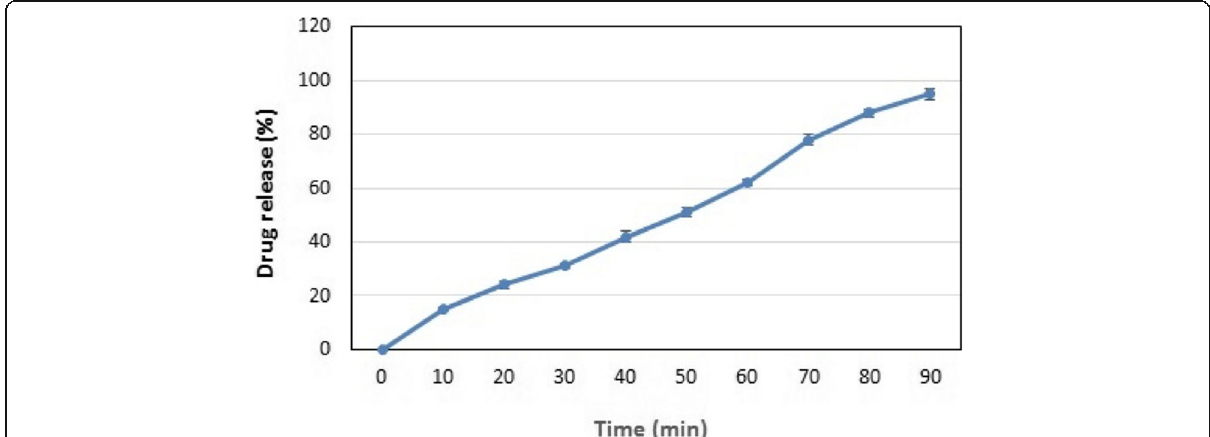
Fig. 4 In vitro drug release profile of prepared atorvastatin-loaded chitosan-hydroxyapatite composite bioscaffolds (Hcc3). Data are represented as mean ± S.D. ( n = 3)